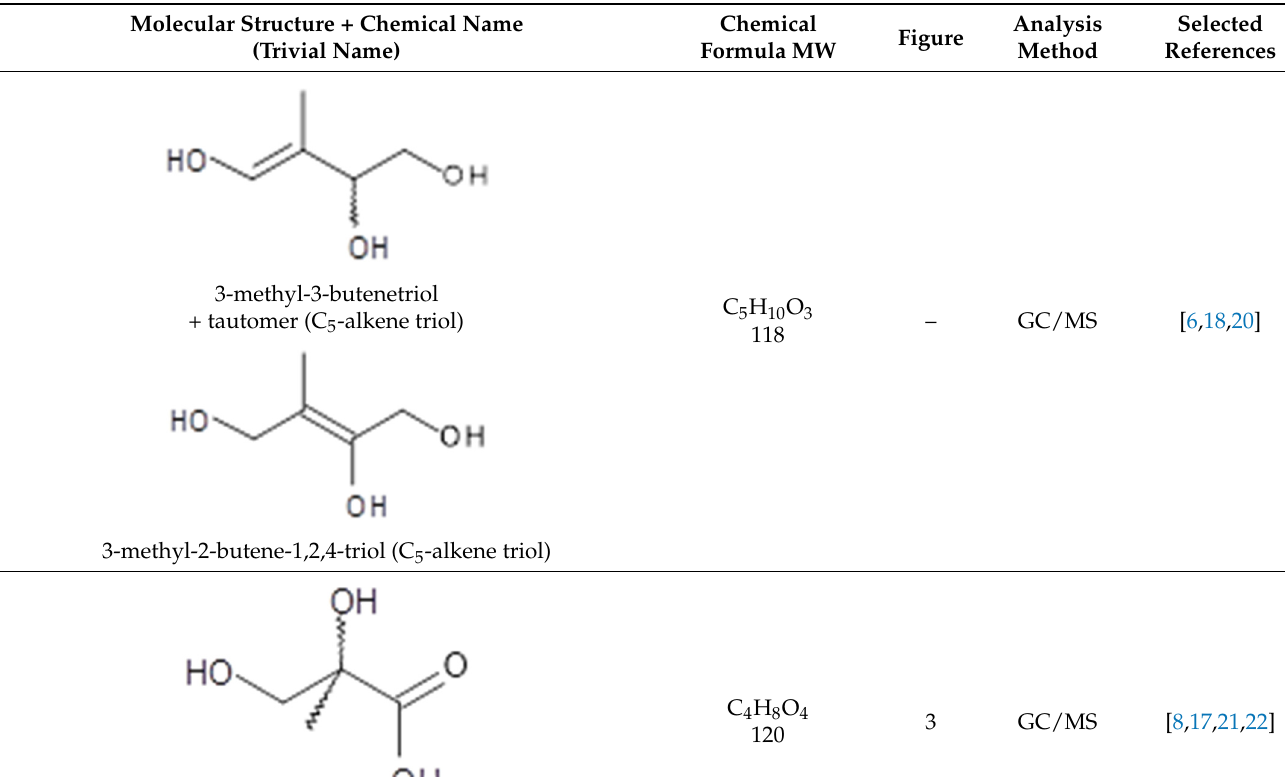
Table 1. Overview of molecular markers for isoprene SOA. Abbreviations: 2-MG, 2-methylglyceric acid; NOS, nitrooxy organosulfate; OS, organosulfate. The compounds are listed according to increasing MW.